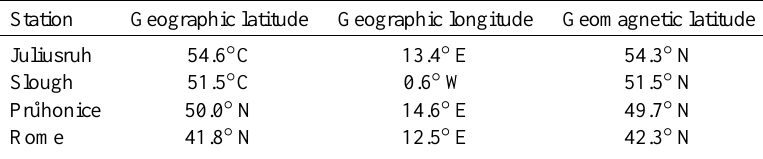
Table 1. Coordinates of ionospheric stations